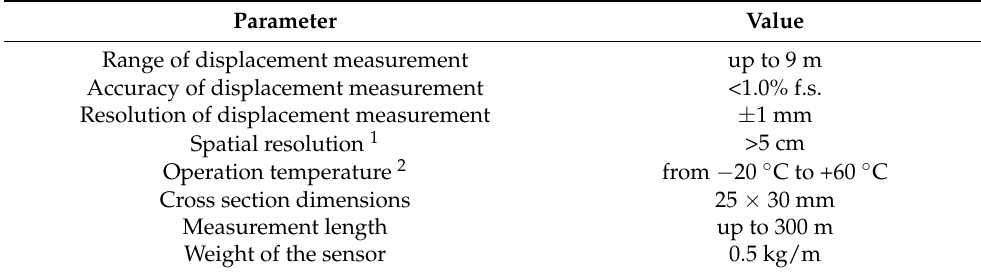
Table 3. Technical specifications of hydraulic sensor for vertical displacement